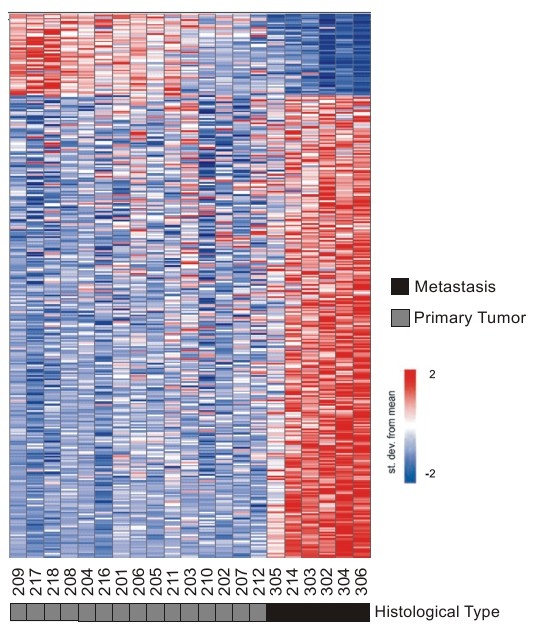
A gene expression signature correlated to metastasis in pancreatic adenocarcinoma. Three hundred fifty five transcripts (rows) identified as differentially expressed (FDR ≤ 5%) between metastatic (dark box) and primary tumor (dark gray) samples from 21 patients (columns). Patient ID numbers are shown below the columns. One hundred thirty four intronic and intergenic lncRNAs were identified, comprising 38% of the metastasis signature. Expression level of each transcript is represented by the number of standard deviations above (red) or below (blue) the average value across all samples. Samples are ordered according to their individual correlation to the average profile of primary tumor samples. Tissue histology is shown below each patient ID.